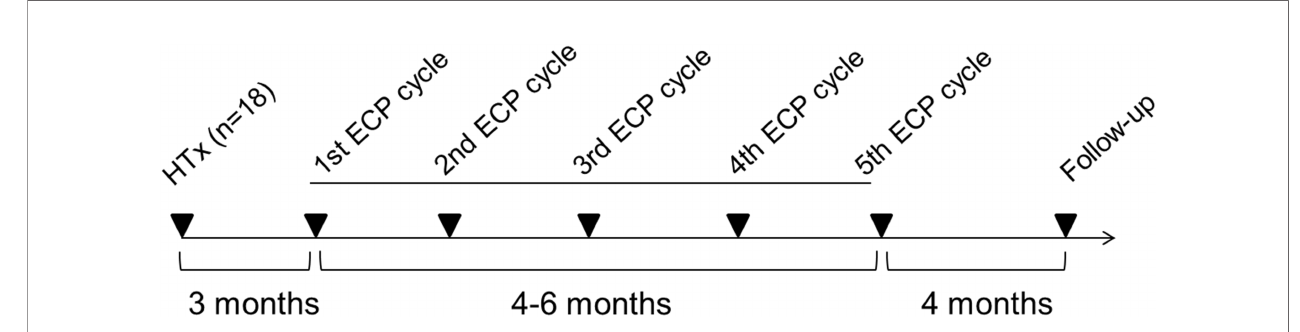
FIGURE 1 | Overview about the treatment regimen for extracorporeal photopheresis. ECP, extracorporeal photopheresis; HTx,